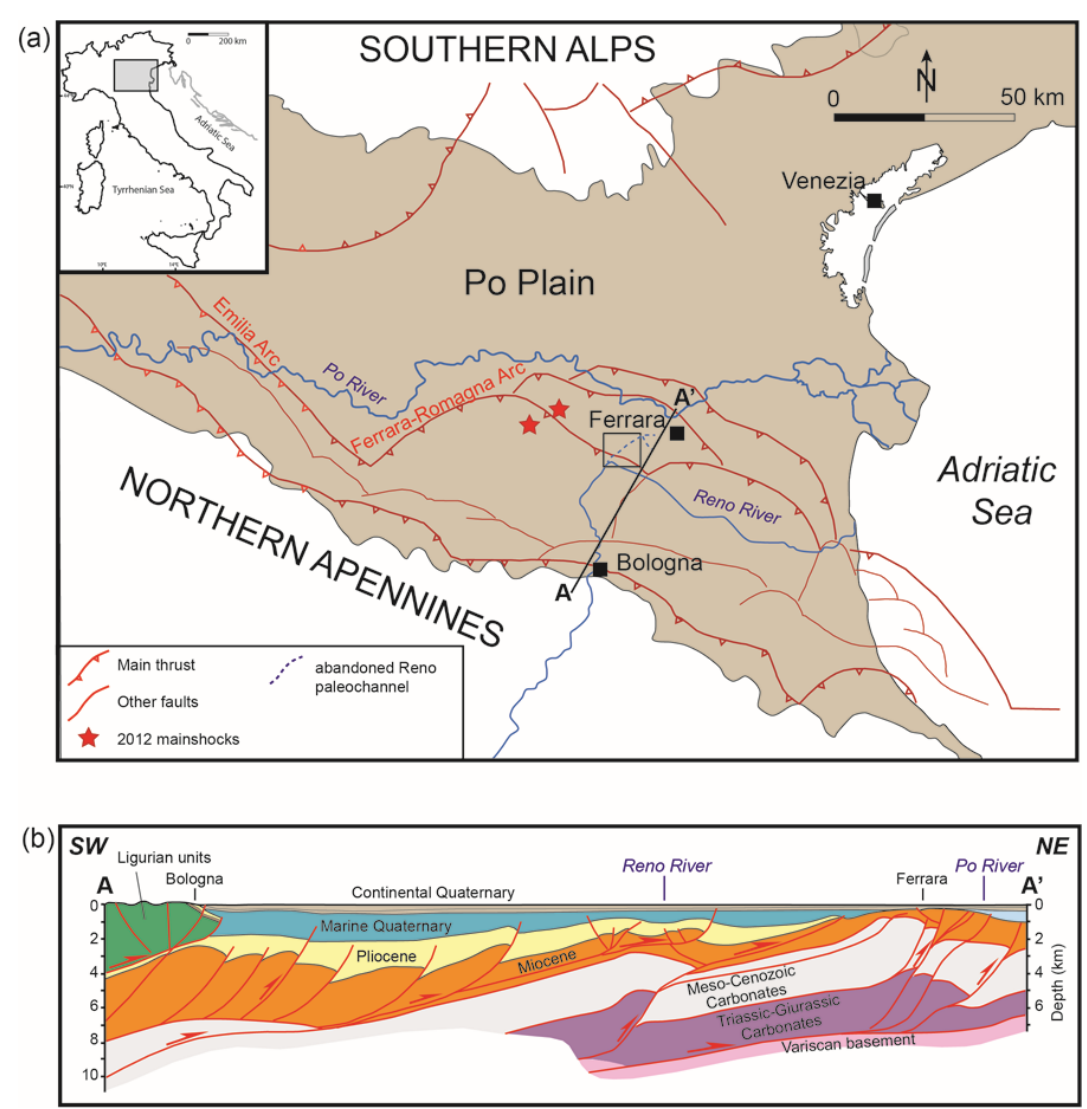
Figure 1. (a) Tectonic sketch map of the Po Plain (northern Italy) showing the main buried faults of the northern Apennines and southern Alps and epicenters of the two mainshock from the 2012 Emilia sequence (red stars) (modified from Tentori et al., 2022 and Bruno et al., 2021). The black-lined rectangle encloses the study area. (b) Simplified stratigraphic cross section and major tectonic structures along the trace A–A (cid:48) in panel (a) (modified after Boccaletti et al., 2004). The tectonic structures are enucleated into Mesozoic to Paleogene carbonate successions and largely controlled the sedimentary evolution of the terrigenous basins during the Neogene (Ghielmi et al., 2013; Rossi et al., 2015; Ricci Lucchi, 1986). The Pliocene–Pleistocene boundary records the transition from turbiditic sedimentation to marine clay deposition, whereas the Quaternary sedimentary fill consists of marine deposits, nearshore sands, and alluvial deposits (see text for